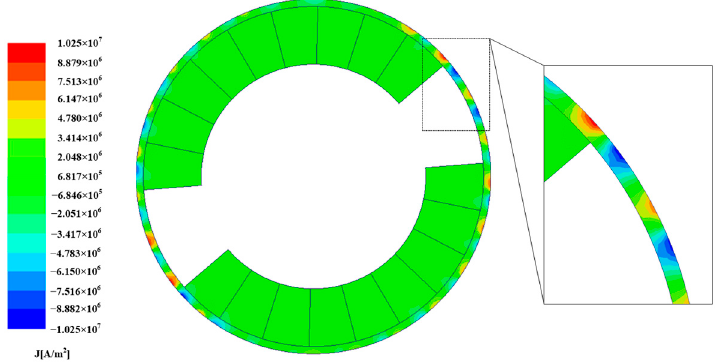
Figure 14. The eddy current density distribution of the permanent magnet and the 2 mm jacket.